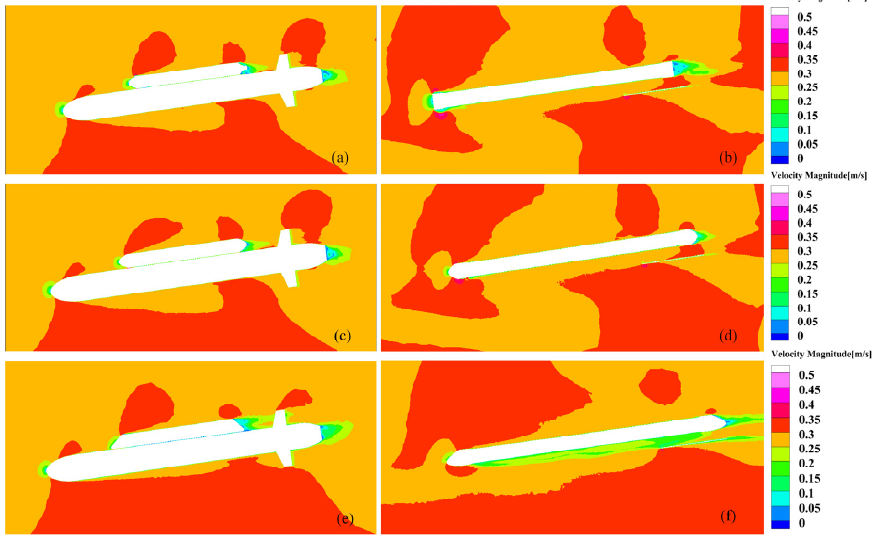
Figure 5. The pressure distribution on the surface and the symmetry planes of the three models are ( a ) flat fairing; ( b ) conical fairing; ( c ) inclined conical fairing. and the heat exchange tubes of the three models are analyzed with v m = 0.3 m/s and α = 8 ◦ , as shown in Figure 6.